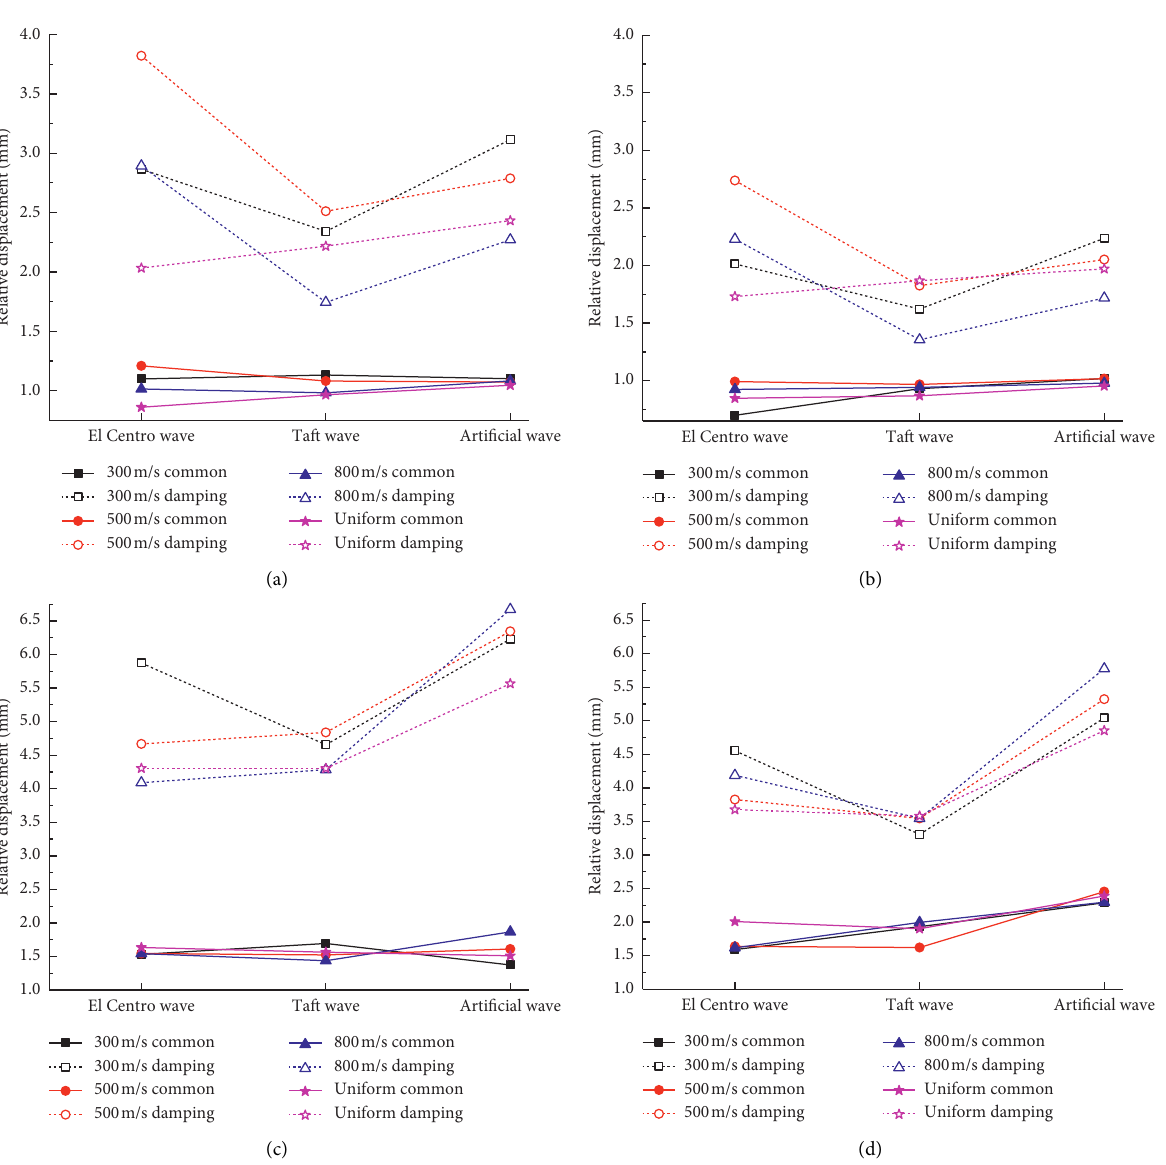
Figure 7: Relative displacement between suspended floors and main structure. (a) The first suspended floor under 9 frequent earthquakes. (b) The top suspended floor under 9 frequent earthquakes. (c) The first suspended floor under 8 rare earthquakes. (d) The top suspended floor under 8 rare